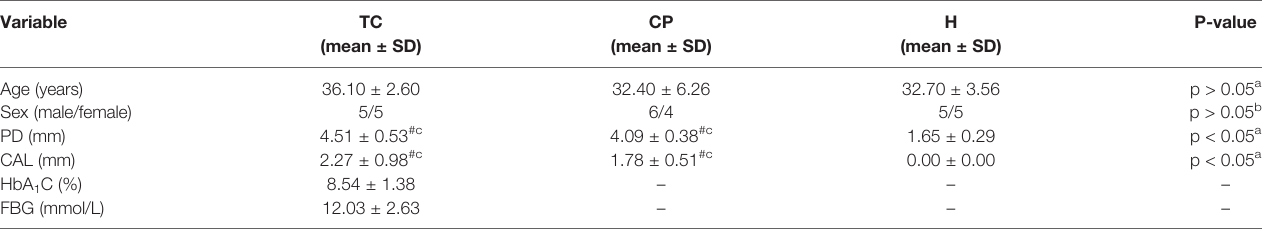
TABLE 1 | Social demographic characteristics and clinical parameters among TC, CP, and H groups.